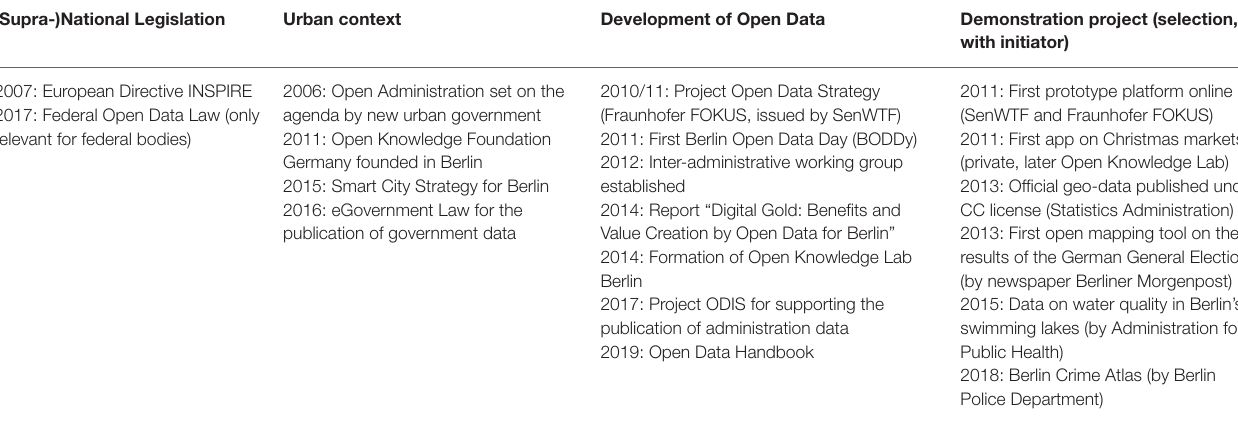
TABLE 3 | Development of Open Data in Berlin (section Setting Open Data as a Stepping Stone for